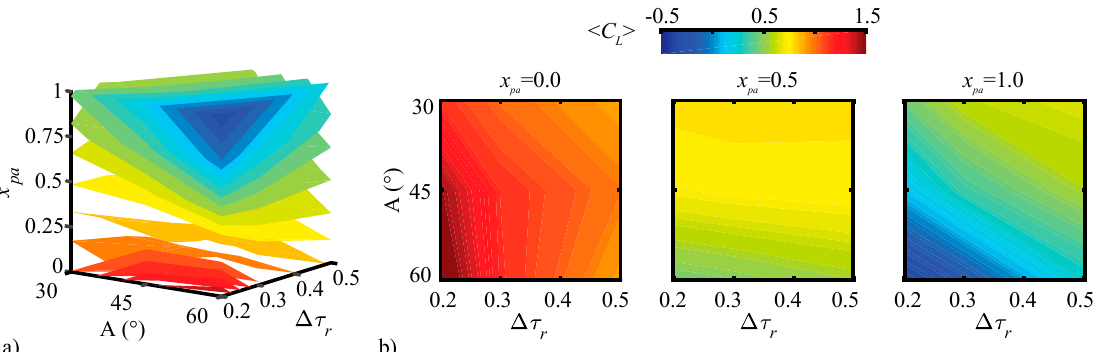
Figure 4. NSe solutions of the cycle-averaged lift coefficient in the design space. ( a ) Iso-surfaces of < C L > in the design space. ( b ) Slices of < C L > in the design space at various x pa values.